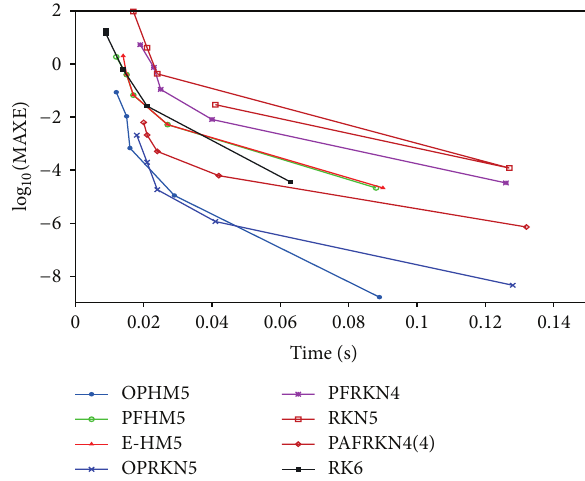
Figure 1: The efficiency curves of the optimized and phase-fitted order five methods and their comparisons for Problem 2 with 𝑡 10 4 and ℎ = 0.125/2 𝑖 , 𝑖 = 1, ...,5 .